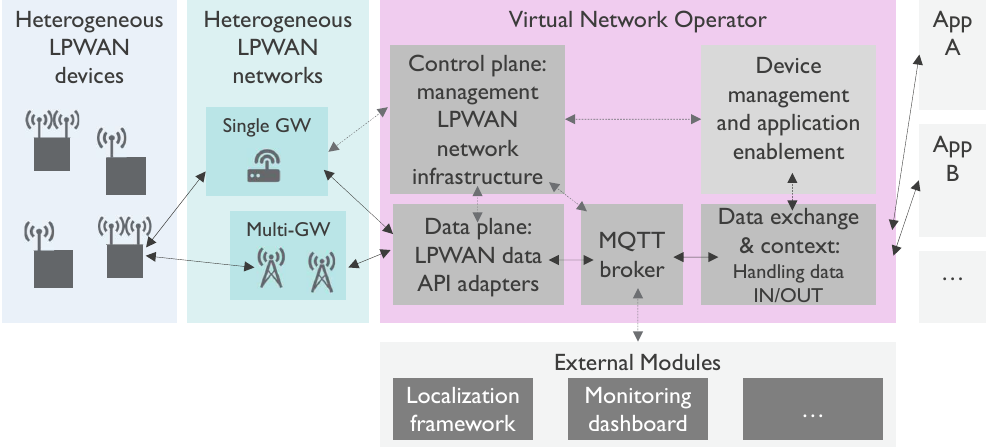
Figure 1. The modular implementation of the Virtual Network Operator allows easy addition of technologies and external modules. For example, a localization framework can extract data from the VNO’s MQTT broker and respond with a location estimate via the same